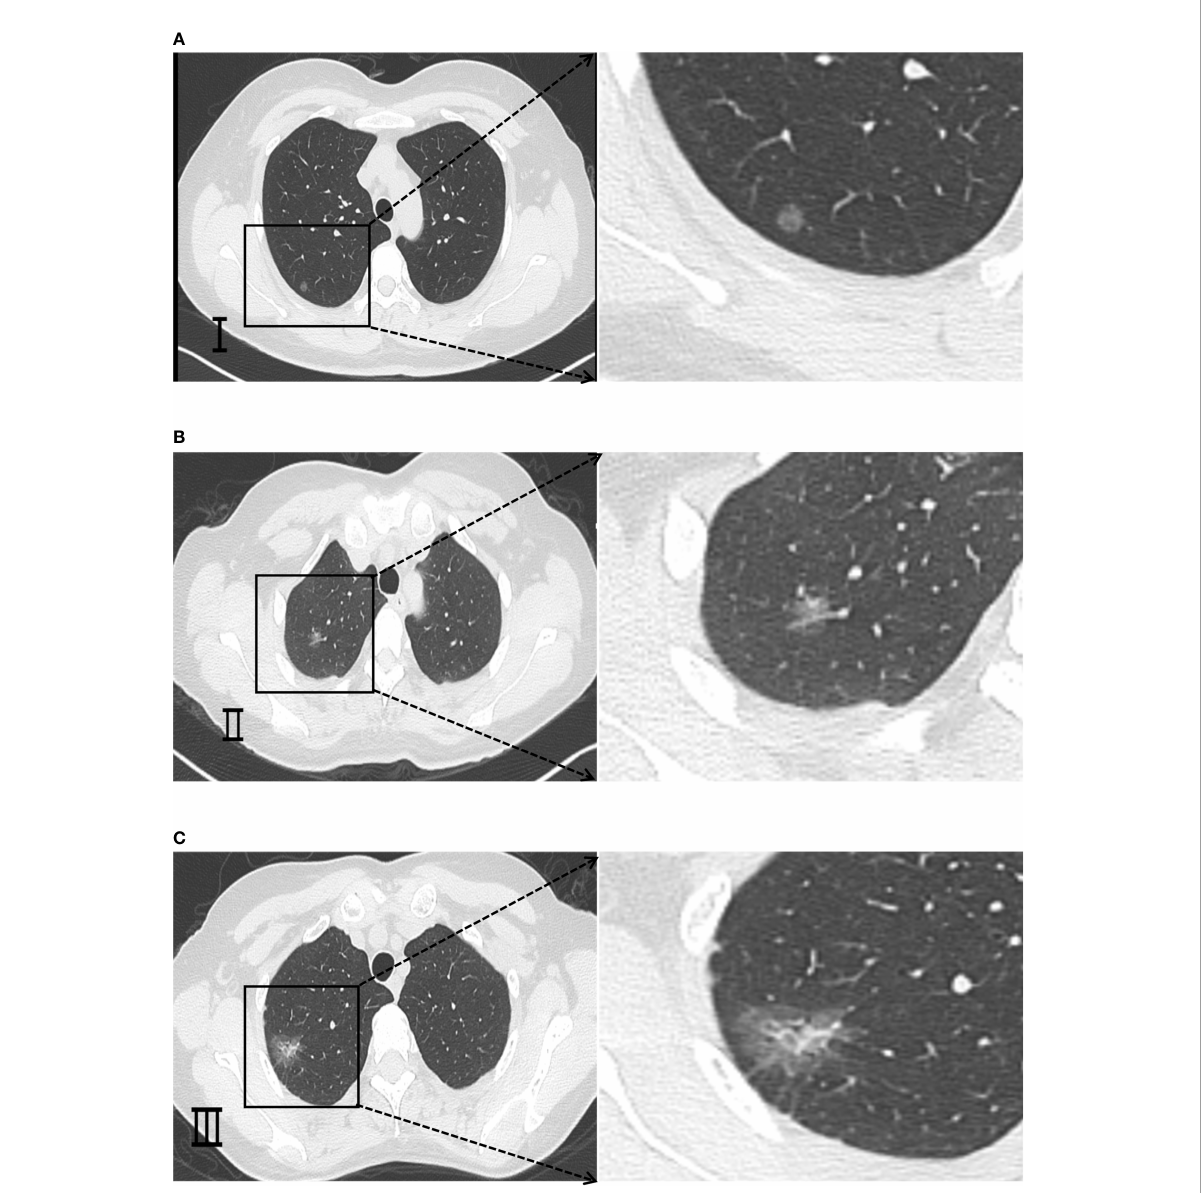
FIGURE 1 Representative CT imaging fi ndings of GGNs classi fi ed according to different morphologies of passing vessels. (A) Type I is a GGN without vascular penetration or with only vessels passing by the side. (B) Type II is a GGN with normal pattern of vessel penetration and no obvious morphological changes in the expected path or thickness of the penetrating vessels. (C) Type III is a GGN with abnormal pattern of vessel penetration, such as thickened, stiffened or twisted vessels and other more complex patterns such as vascular clustering sign,